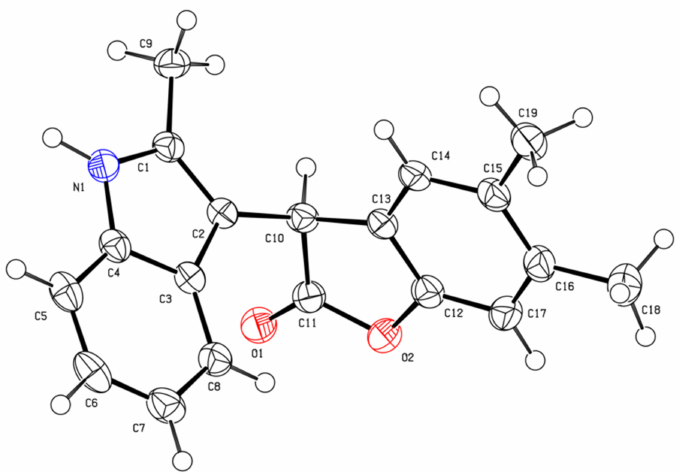
Figure 1. ORTEP drawing of X-ray structures of 5,6-dimethyl-3-(2-methyl-1 H -indol-3-yl)benzofuran- 2(3 H )-one ( 6aa , CCDC #2154293). The thermal ellipsoids are shown at 50%